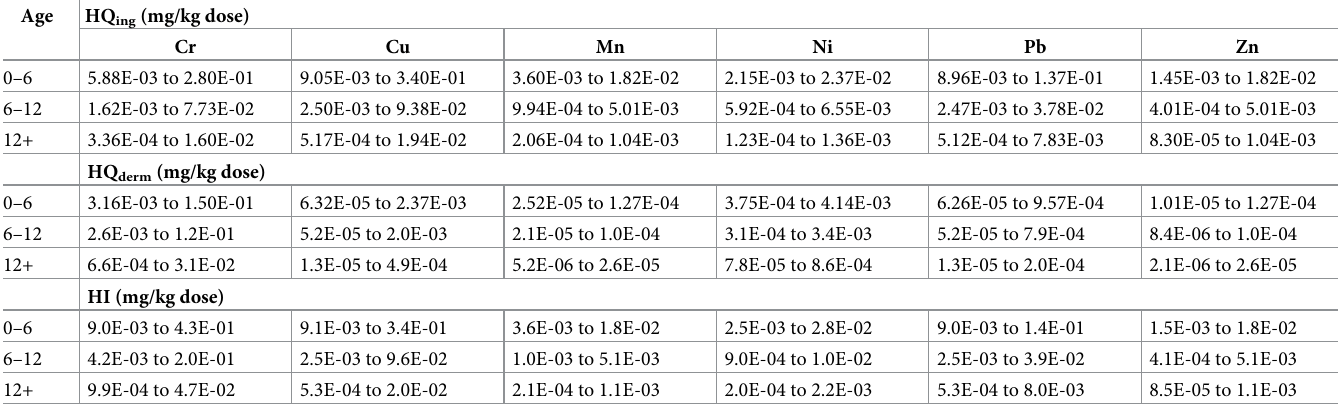
Table 2. Exposure dose, hazard quotient for each element and exposure